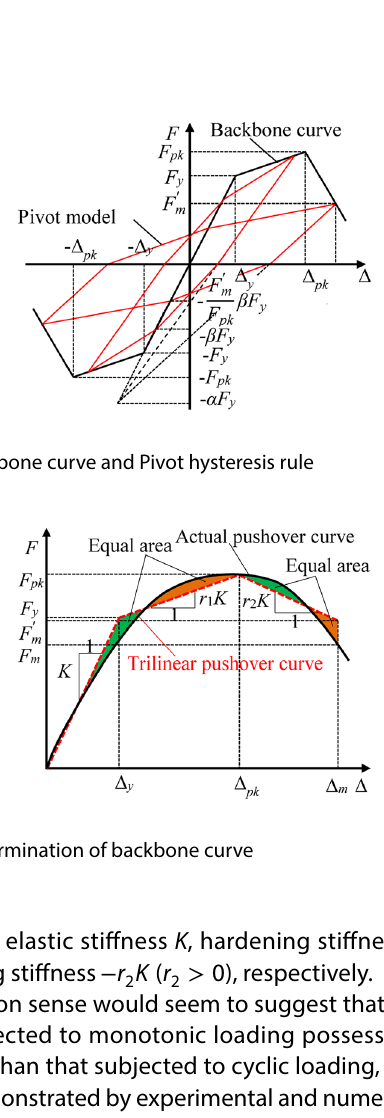
Fig. 1 Analytical model of pile-supported wharf and corresponding SDOF model